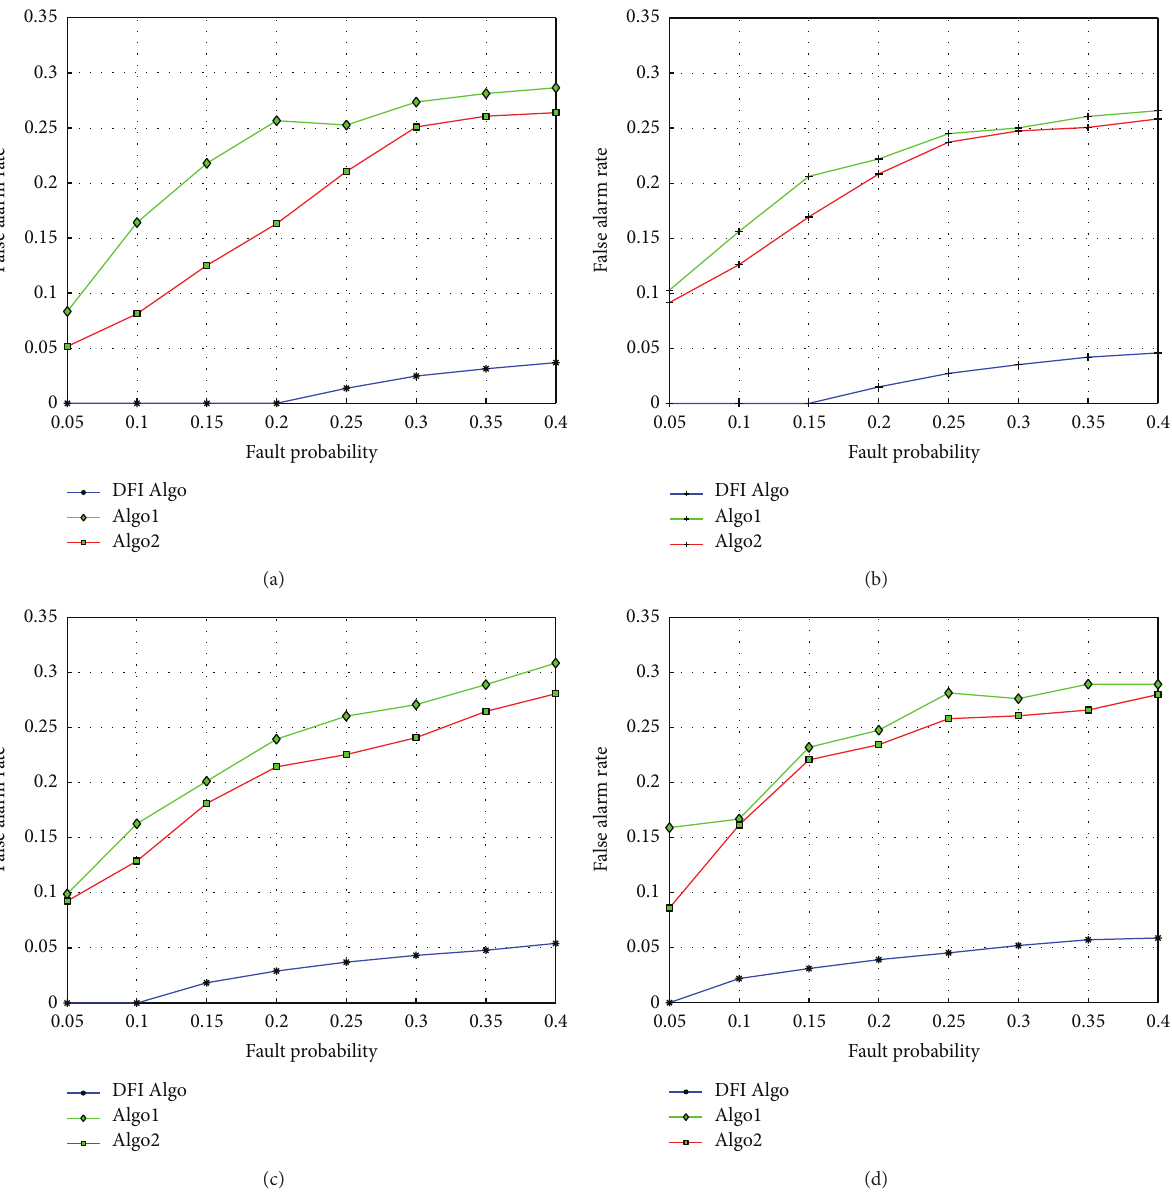
Figure 3: FAR versus fault probability plots for the proposed DFI, Algo1, and Algo2 algorithms: (a) for average degree 𝑁 𝑎 = 10; (b) for average degree 𝑁 𝑎 = 15; (c) for average degree 𝑁 𝑎 = 20; (d) for average degree 𝑁 𝑎 =